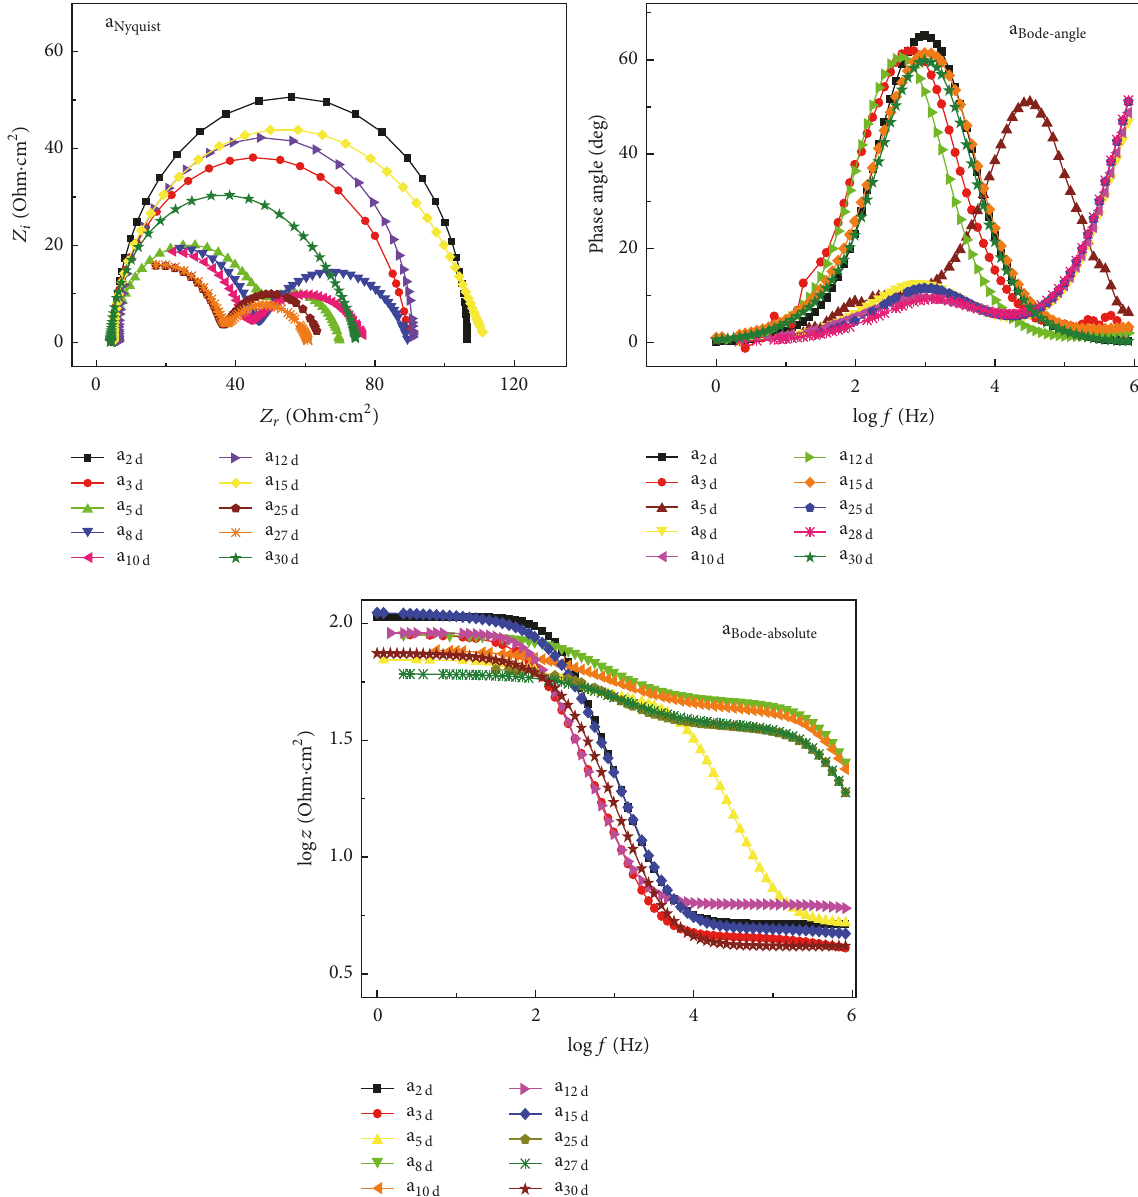
Figure 4: 2024-T31 aluminum-magnesium alloy was immersed in a test system 2–30 d of the Nyquist plot and Bode plot.